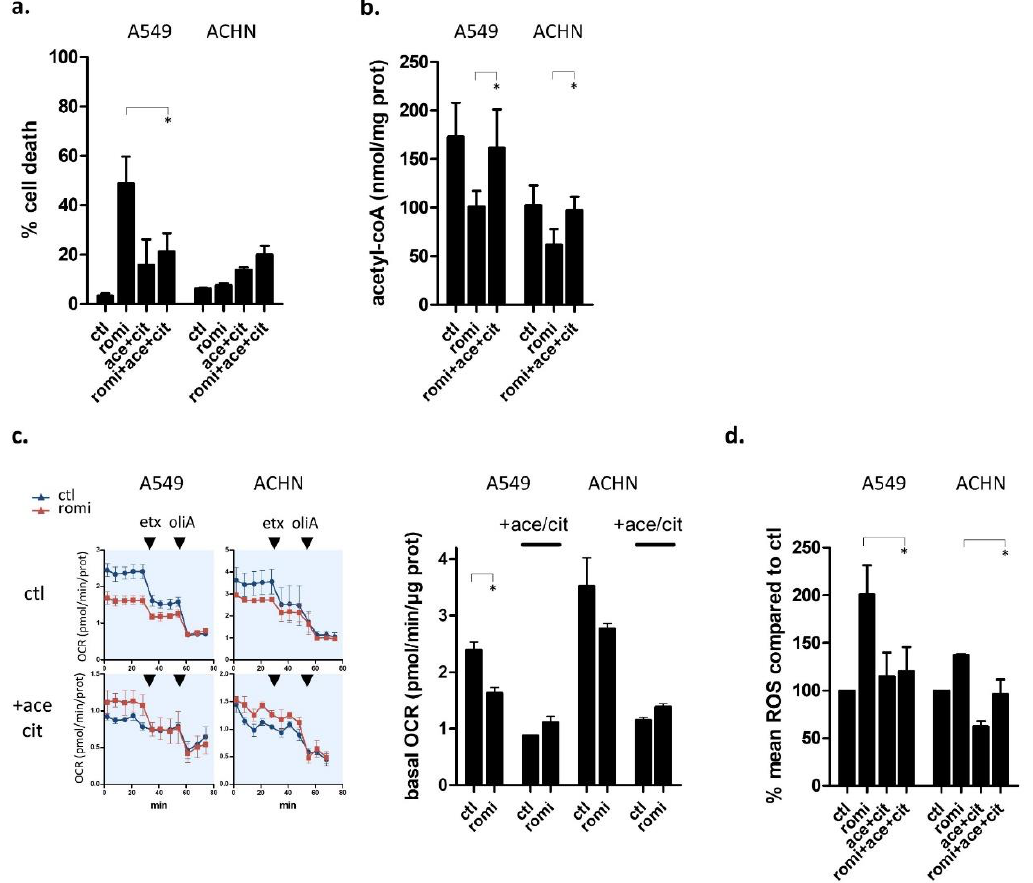
Figure 5. Acetyl-CoA precursors replenish acetyl-CoA stock and rescue KRAS-mutant cells from metabolic stress. ( a ) Cell death was measured by flow cytometry (annexin-V positive cells) in cells treated or untreated for 48 h with romidepsin (clinical dosing), in the presence or absence of 20 mM acetate + 5 mM citrate. ( b ) Acetyl-CoA was quantified by mass spectrometry in KRAS-mutant (A549) and KRAS-WT (ACHN) cell lines treated or untreated with romidepsin (18 h), in presence or absence of 20 mM acetate + 5 mM citrate. ( c ) OXPHOS (OCR) was measured in cells treated or untreated for 18 h with romidepsin, in presence or absence of 20 mM acetate + 5 mM citrate followed by addition of 40 µM etomoxir then 5 µM oligomycin A ( left ). Basal OCR level for romidepsin-treated and untreated cells was calculated and plotted according to presence or absence of acetyl-CoA precursors in medium ( right ). ( d ) ROS production was measured by flow cytometry (DCF-DA) in cells treated or untreated for 24 h with romidepsin, in presence or absence of 20 mM acetate + 5 mM citrate. For all graphs, data are plotted as mean ± SD, and statistical difference was assessed using an unpaired two-tailed Student’s t -test (* indicates a p -value <